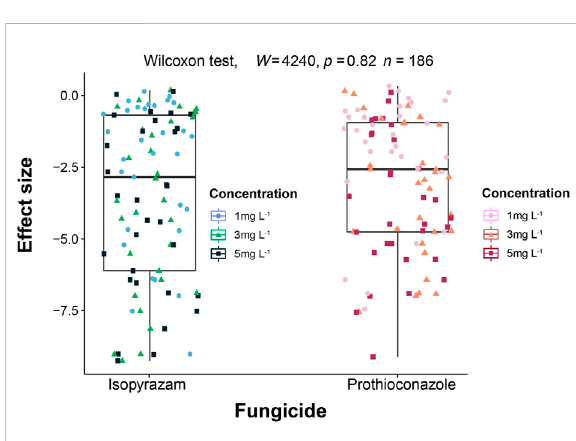
FIGURE 1 Comparison of the effect sizes on fungal colony extension rate between isopyrazam and prothioconazole. Effect sizes (ES) arecalculatedasthenaturallogarithmoftheresponseratiosofthe treatment and control mean values (LRR = ln ( (cid:1) X t / (cid:1) X c ). Data points presented in each box plot represent the ES for individual isolate treated with 1 mg L − 1 (red circle), 3 mg · L − 1 (yellow triangle) and 5 mg · L − 1 (green square) of the fungicide (Wilcoxon test, p =